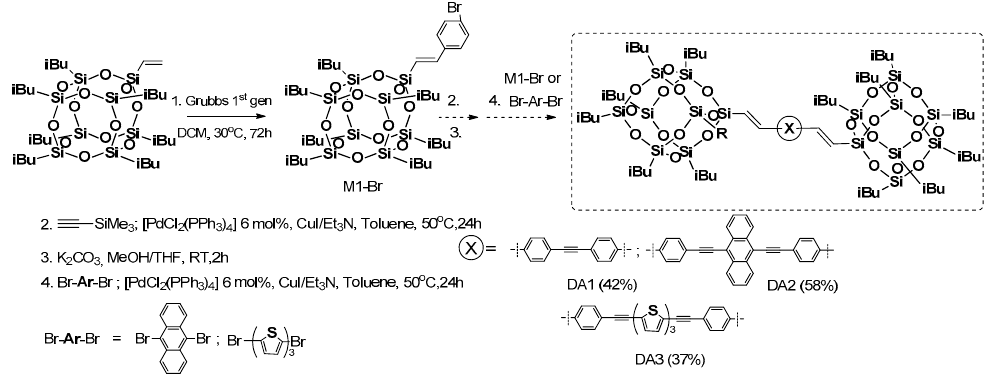
Figure 17. Synthetic reaction route based on sequential cross-metathesis and Sonogashira coupling for dumbbell-shaped π -conjugated systems with POSS as pendant groups.